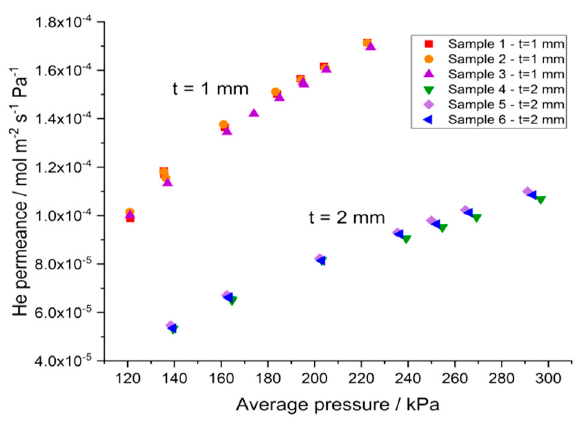
Figure 5. ( a ) Conceptual scheme of the experimental setup for high temperature O 2 permeation tests; ( b ) configuration of the supported membrane during permeation tests.